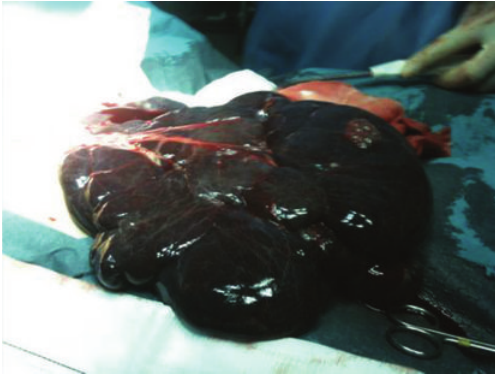
Figure 3: Membranous bag containing blood.